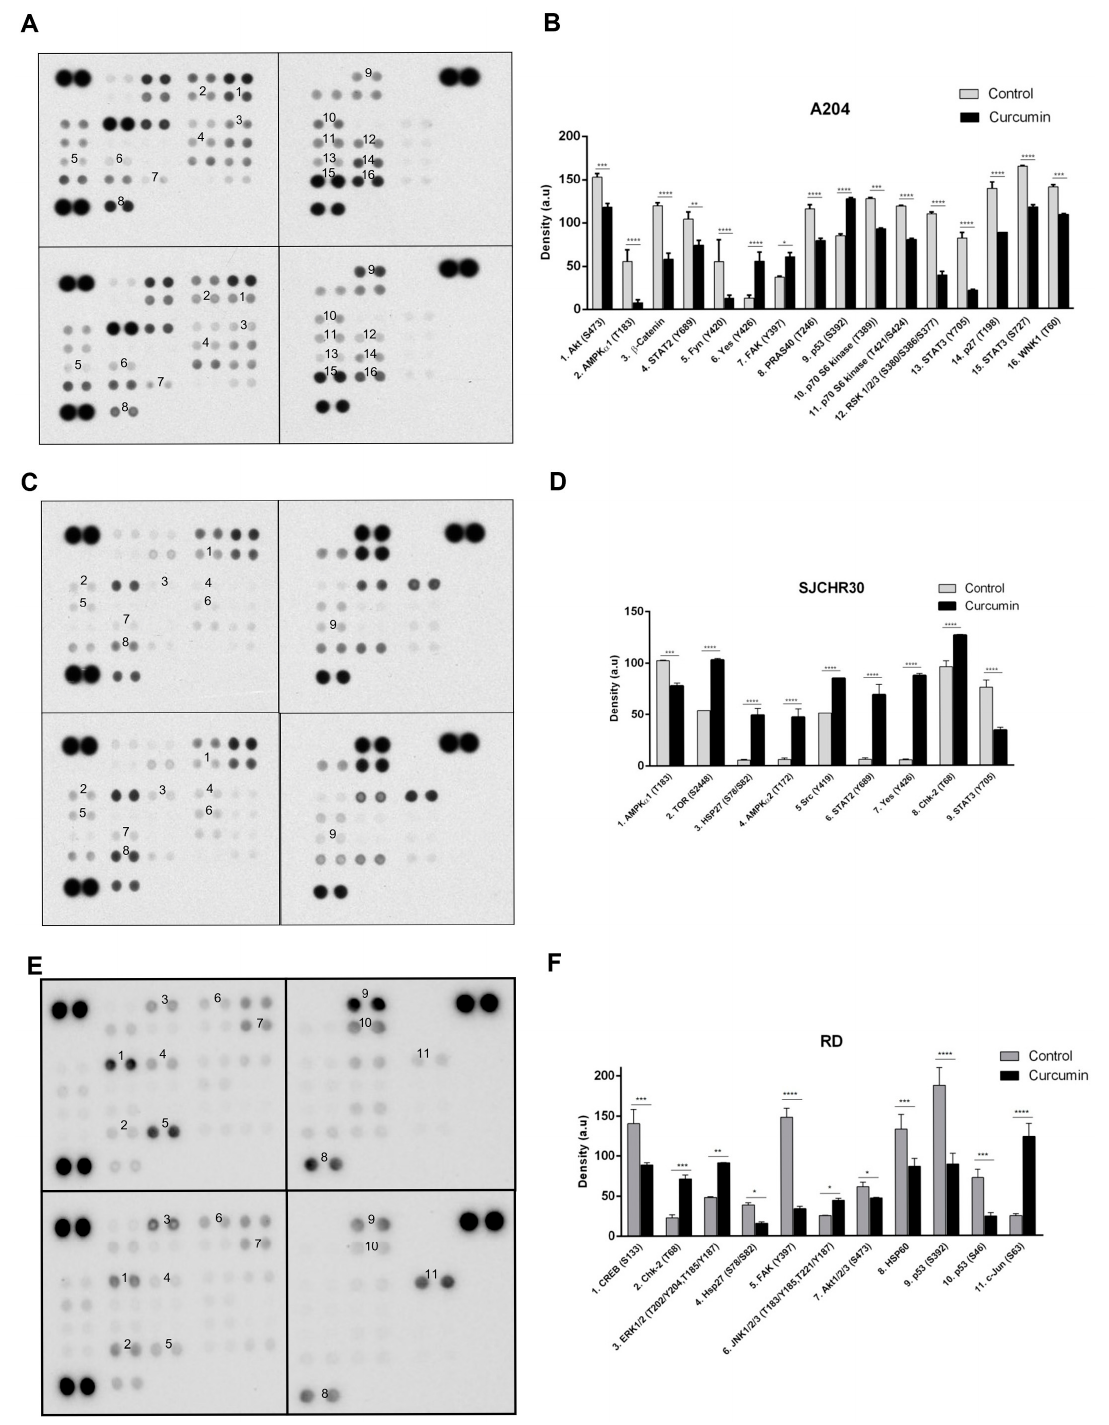
Figure 4. Curcumin influences signaling through AKT/mTOR, STAT, AMPK, and p53 associated pathways. ( A , C , E ) Whole cell lysates prepared from A204 ( A , B ), RH30 ( C , D ), and RD ( E , F ) cell lines that were treated with DMSO (control) or 20 µ M curcumin for 24 h were analyzed using Proteome Profiler Phospho-Kinase arrays. Exemplary array blots are shown. ( B , D , F ) Percent changes in spot density of Proteome Profiler array proteins/phospho-proteins of interest that were quantified using ImageJ software and normalized to positive controls on the same membrane. * p < 0.05, ** p < 0.01, *** p < 0.001, **** p <